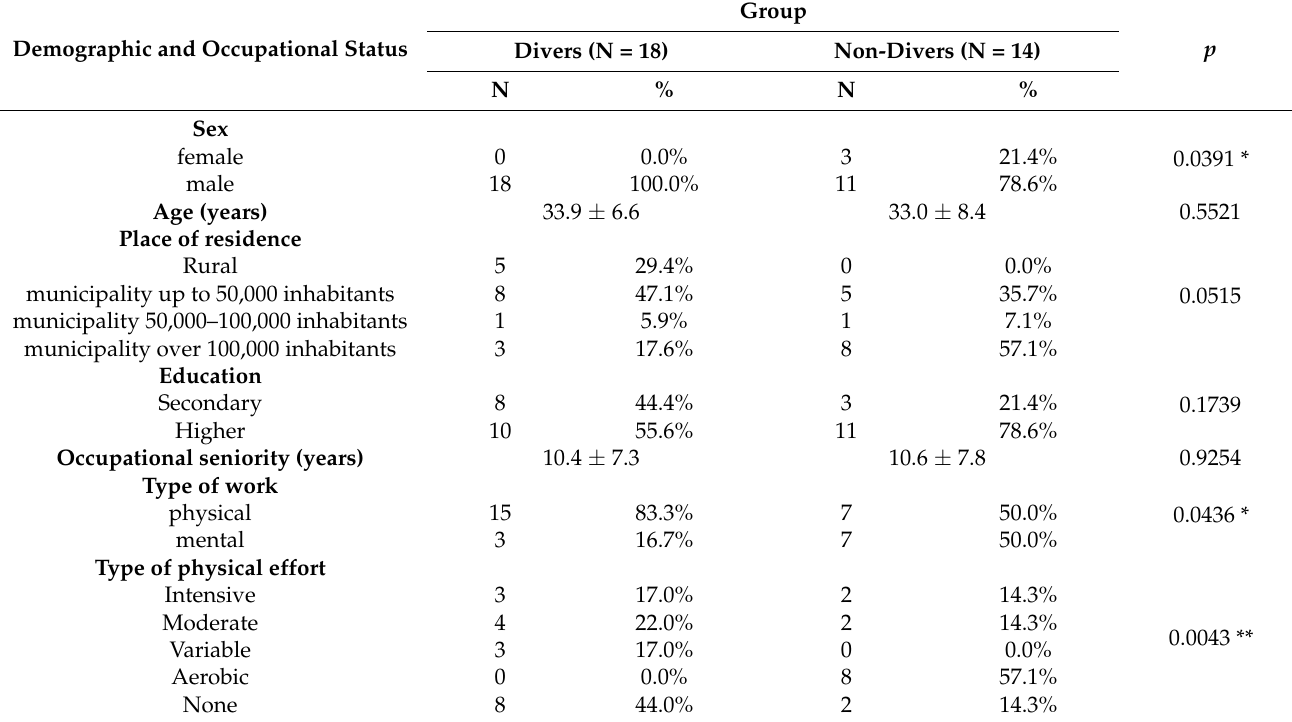
Table 2. Demographic and occupational status of